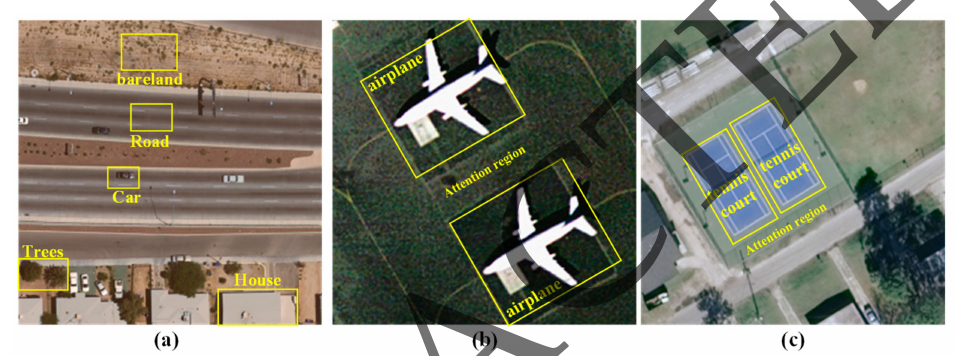
Figure 1. The salient and redundant objects in scenes and the attention mechanism. ( a ) Useful objects, including roads and cars and other redundant objects for classifying the freeway category. ( b ) Attention regions of scenes for airports. ( c ) Attention regions of scenes for tennis courts.